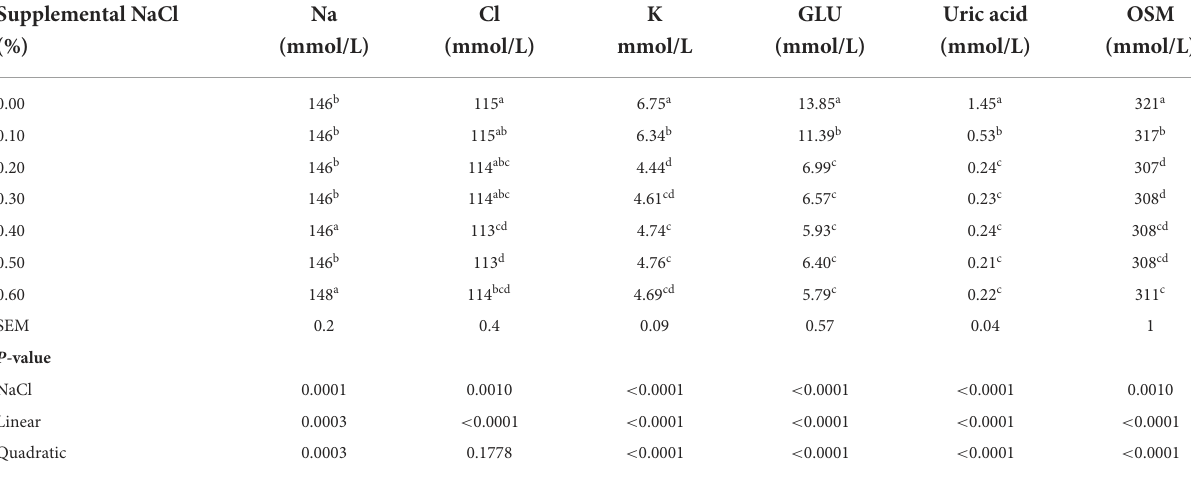
TABLE 5 Effect of dietary NaCl supplemental level on serum biochemical variables of broilers on day 21 1